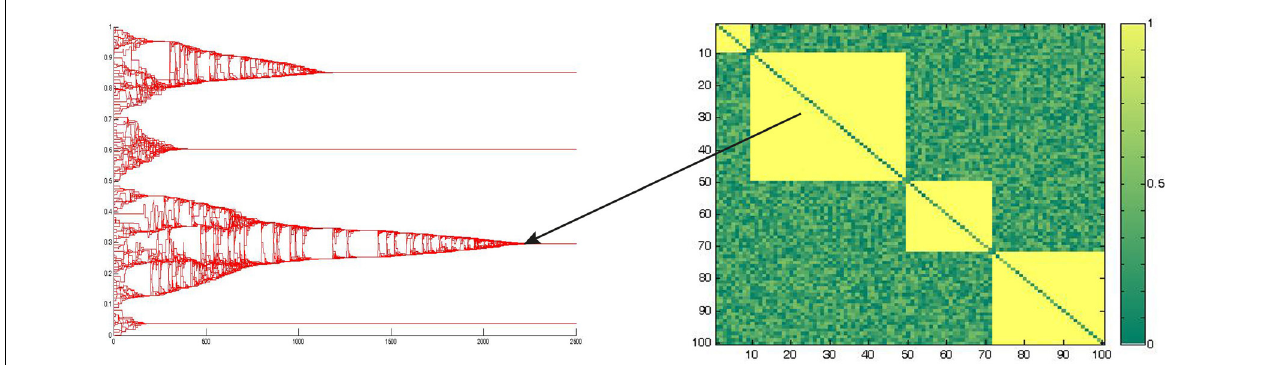
FIGURE 3 | Stable state of the group dynamics. An example of stable state condition of the system at the end of a typical simulation run is reported. On the left the opinion space of the group, on the y-axis, is represented with